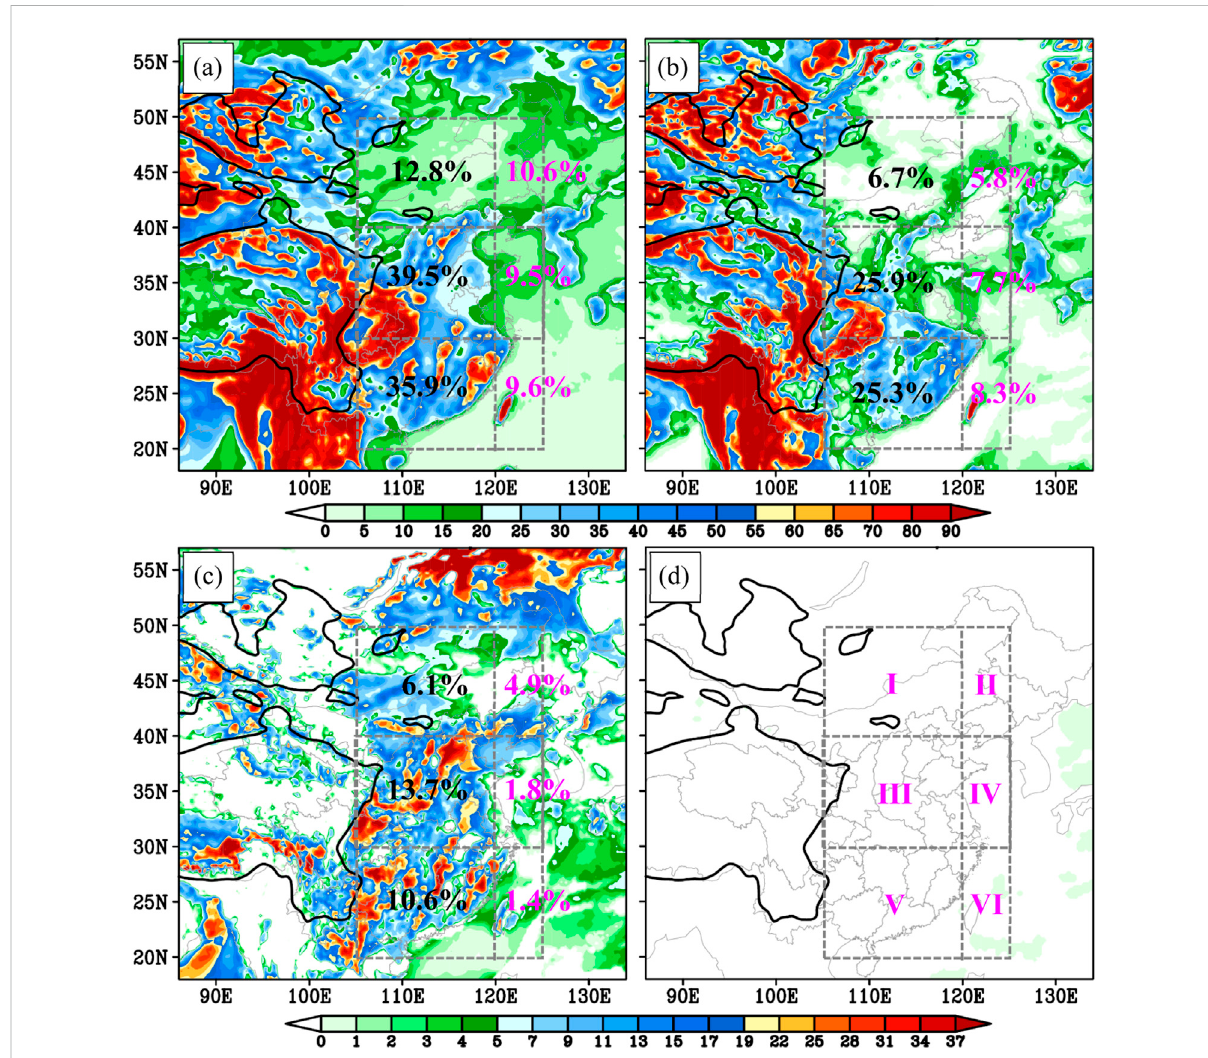
FIGURE 12 (A) Percentage of zero wind power generation due to low wind velocity (calculated using the wind speed at 100 m above the ground level) during the winters of 2016 – 2020 (shading; %). Thick black line = terrain at 1,500 m. Gray dashed boxes = six comparison areas (I-VI; Figure 12D). Numbers = region-averaged percentages, respectively. (B) Same as that of (A) , but for the period during the cold wave event discussed in this study. (C) Results of the calculations of (A) minus (B) . (D) Same as (C) but for the high-wind-velocity cut-out percentage (shading;